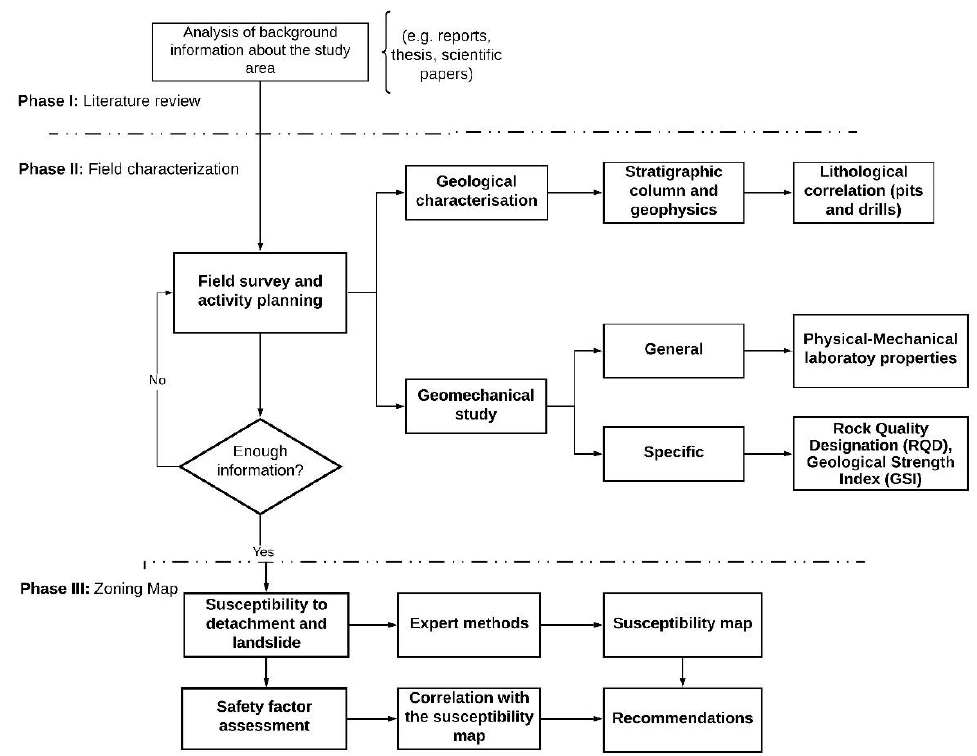
Figure 2. The proposed methodology for this study.